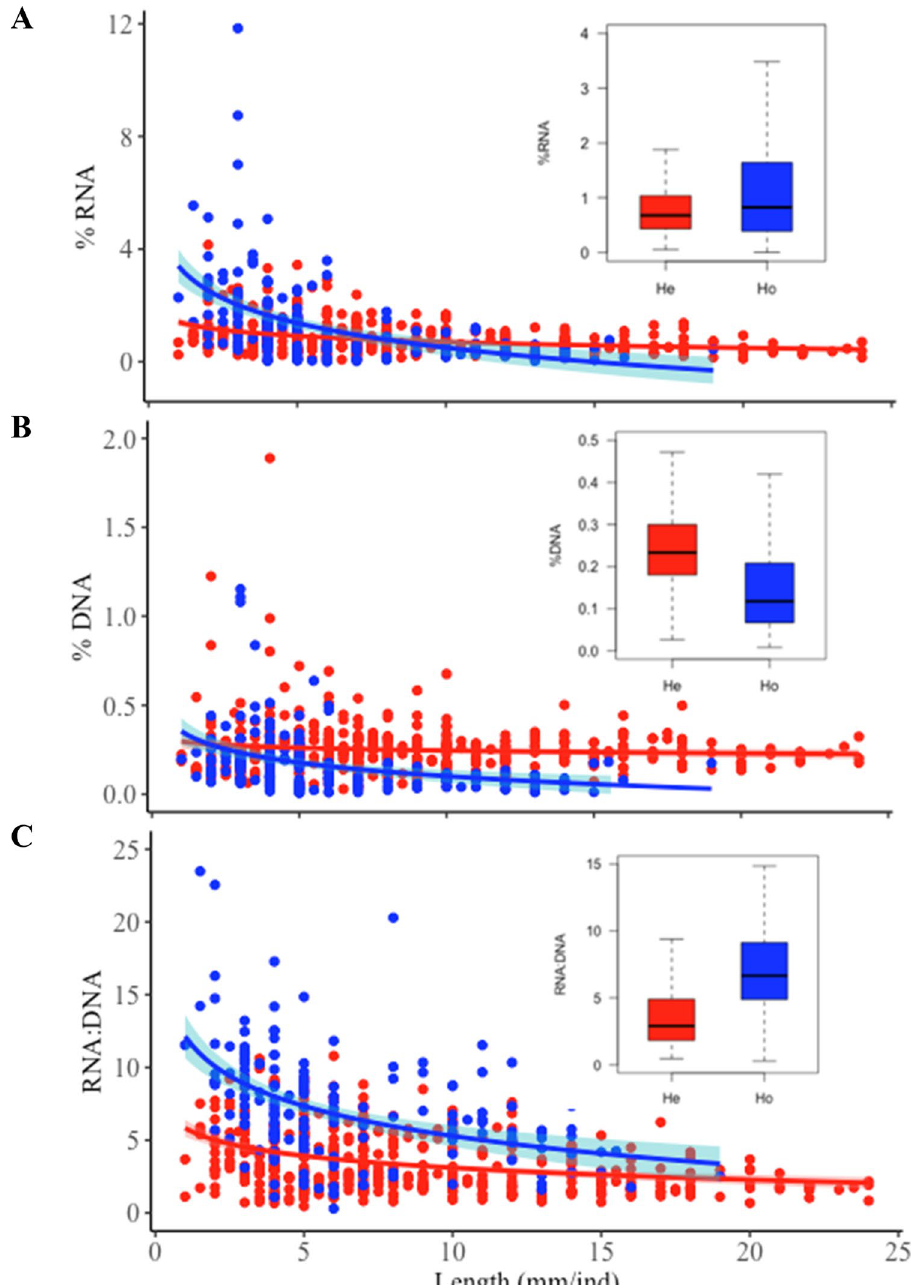
Figure 1. Relationships between body length and nucleic acids. All fits shown were significant and model parameters and statistics for ( A ) RNA, ( B ) DNA and ( C ) RNA:DNA ratio are shown in Table 2. Lines indicate Generalized Linear Model fit and shadows indicate 95% confidence intervals for each fit. Inset box plots display variation in the centerline representing median values, boxes extending to the first and third quartiles, and whiskers to the 1.5 × the interquartile